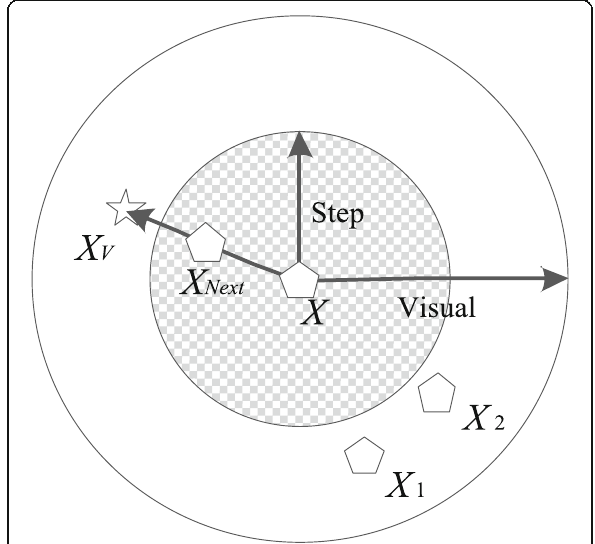
Fig. 3 Visual concept map of artificial